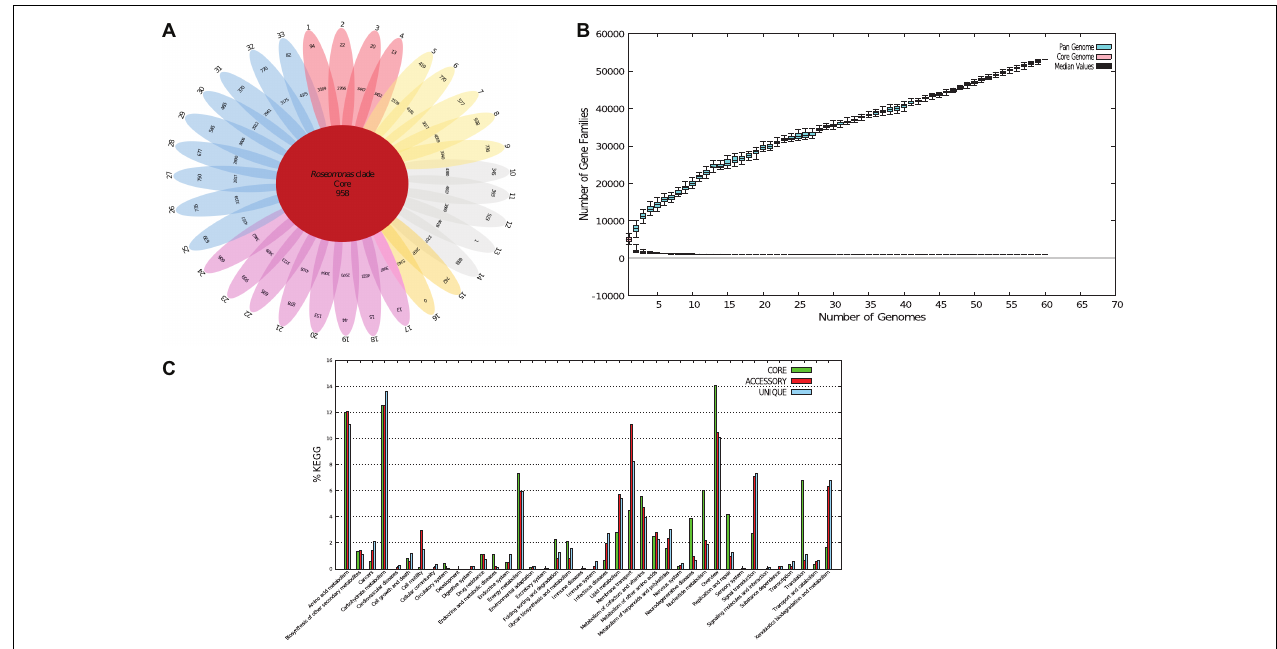
FIGURE 3 | Core-pan-genome analysis of Roseomonas type strains. (A) Flower-pot diagram representing core, accessory, and unique genomes of the genomes of all strains. (B) Core-pan-plot for all the genomes. (C) KEGG distribution of core, accessory, and unique genes (1. R. gilardi subsp. rosea ATCC BAA-691 T ; 2. R. gilardi subsp. rosea NCTC 13290 T ; 3. R. mucosa ATCC BAA-692 T ; 4. R. mucosa NCTC 13291 T ; 5. R. rosea DSM 14916 T ; 6. R. aerilata DSM 19363 T ; 7. R. pecuniae N75 T ; 8. R. sp. vinacea DSM 19362 T ; 9. R. harenae CPCC 101081 T ; 10. R. stagni DSM 19981 T ; 11. R. algicola PeD5 T ; 12. R. bella CQN31 T ; 13. R. frigidaquae JCM 15073 T ; 14. R. selenitidurans BU-1 T ; 15. R. arctica LMG 28251 T ; 16. “R. hellenica” LMG 31523 T ; 17. R. oryzicola KCTC 22478 T ; 18. R. oryzicola LMG 31230 T ; 19. R. alkaliterrae DSM 25895 T ; 20. R. alkaliterrae LMG 31230 T ; 21. R. lacus CGMCC 1.3617 T ; 22. R. eburnea LMG 31228 T ; 23. R. terrae LMG 31159 T ; 24. R. soli LMG 31523 T ; 25. R. deserti M3 T ; 26. R. aerophila NBRC 108923 T ; 27. R. cervicalis ATCC 49957 T ; 28. R. coralli M0104 T ; 29. R. ludipueritiae DSM 14915 T ; 30. R. oryzae KCTC 42542 T ; 31. R. rhizosphaerae YW11 T ; 32. R. vastitatis CPCC 101021 T ; 33. R. wenyumeiae Z23 T